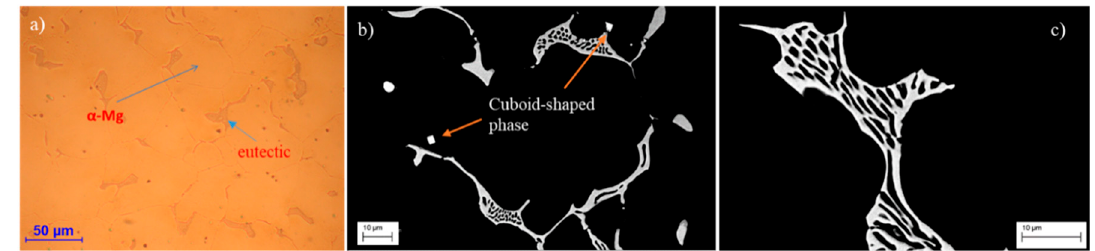
Figure 2. Microstructure of WE43: ( a ) Optical Microscope (OM) of the base material unattached showing the α -Mg grain structure and grain boundary eutectic structures, ( b ) backscattered electron (BSE) image illustrating the cuboidal intermetallic particles (precipitates) and the grain boundary eutectic structures ( c ) BSE image enlarged of the eutectic structure.